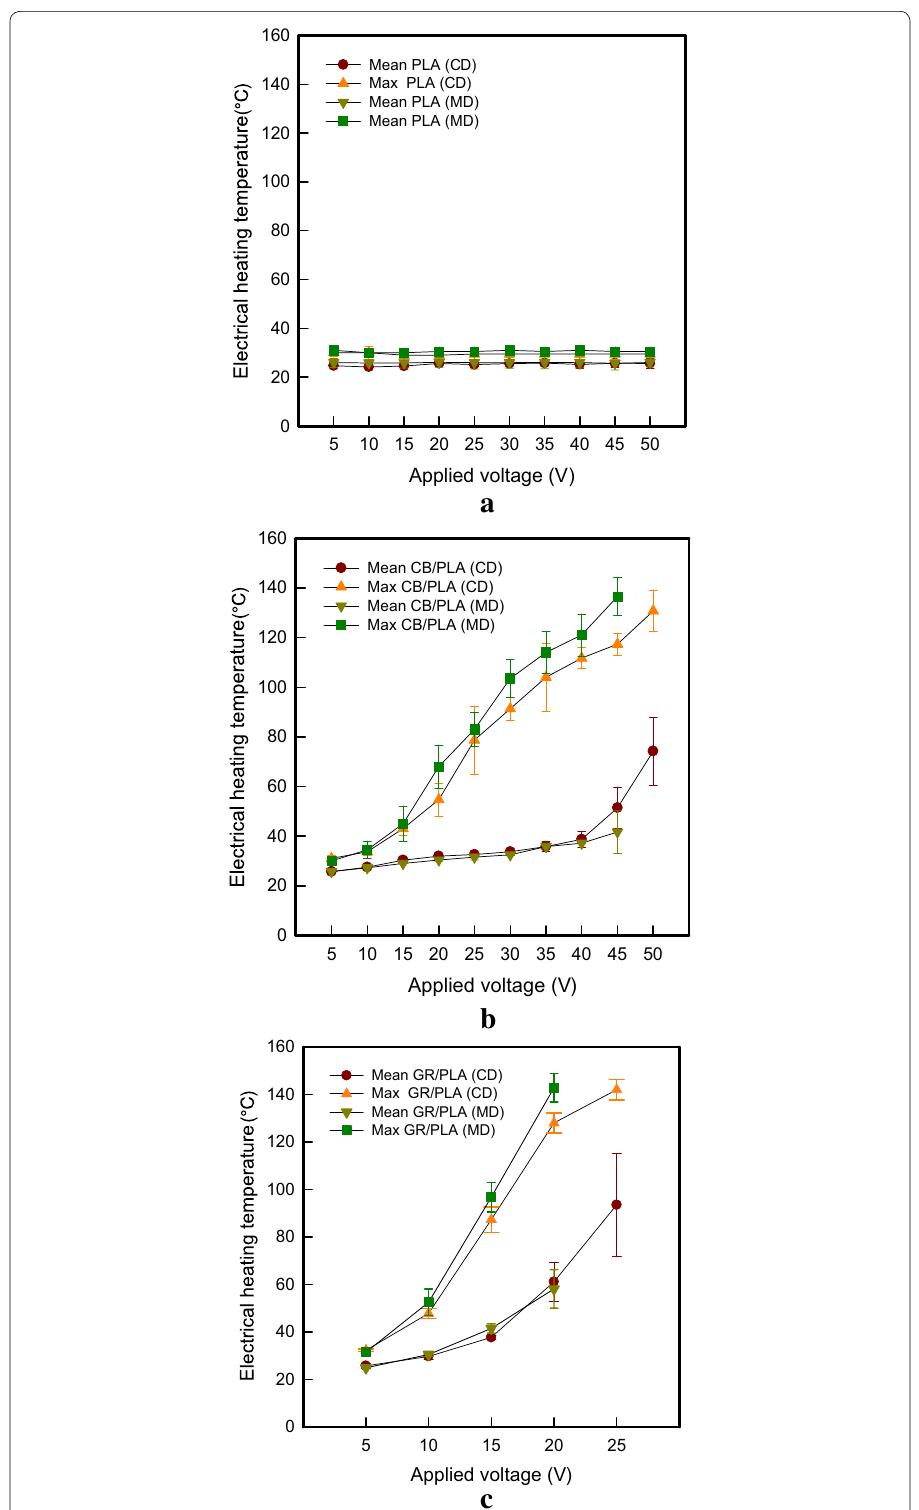
Fig. 6 Surface temperature of 3D printed honeycomb samples of a PLA, b carbon black/PLA, and c graphene/PLA with various